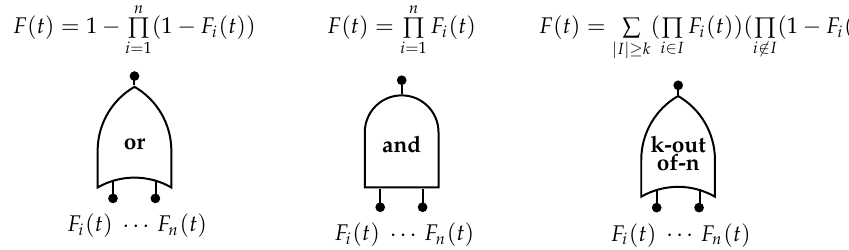
Figure 3. Cumulative distribution function F ( t ) for the gate output ( and, or, k-out-of-n